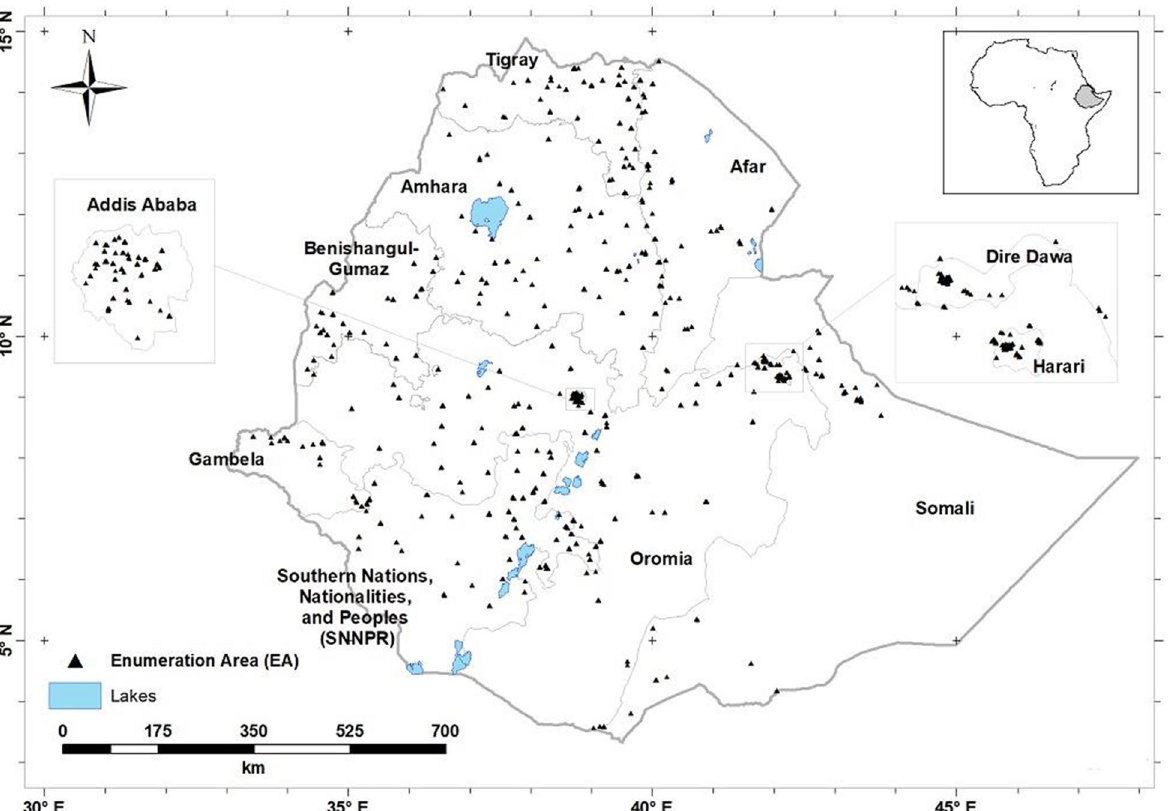
Figure 5. Locations of the centroids of n = 343 Enumeration Areas from which study participants were recruited 15 . Created using ArcGIS 10.4.1. ESRI ArcGIS Desktop: Release 10. Environmental Systems Research Institute, Redlands.